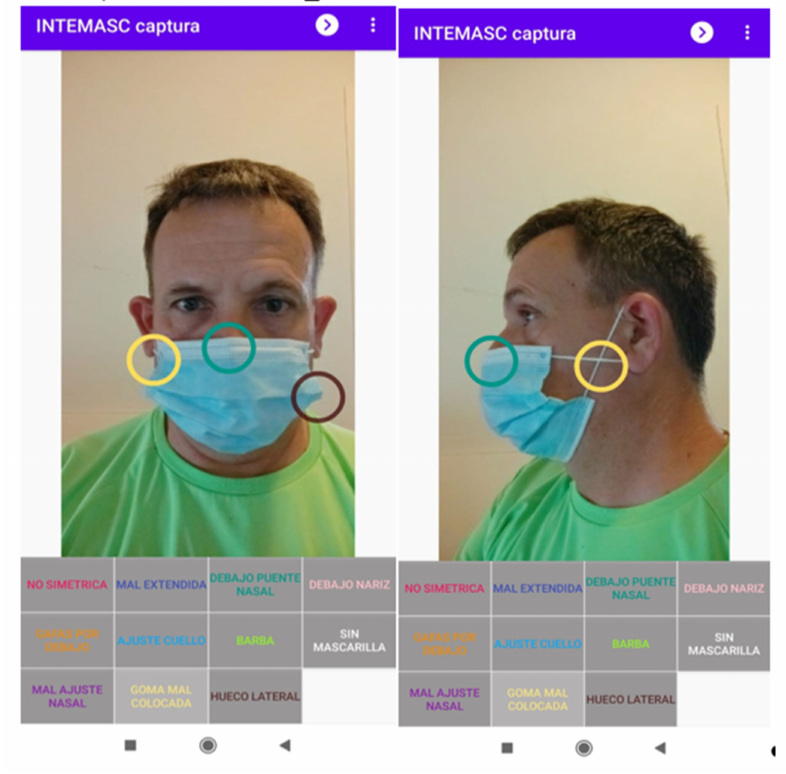
Figure 2. Application for the labeling of the training set.